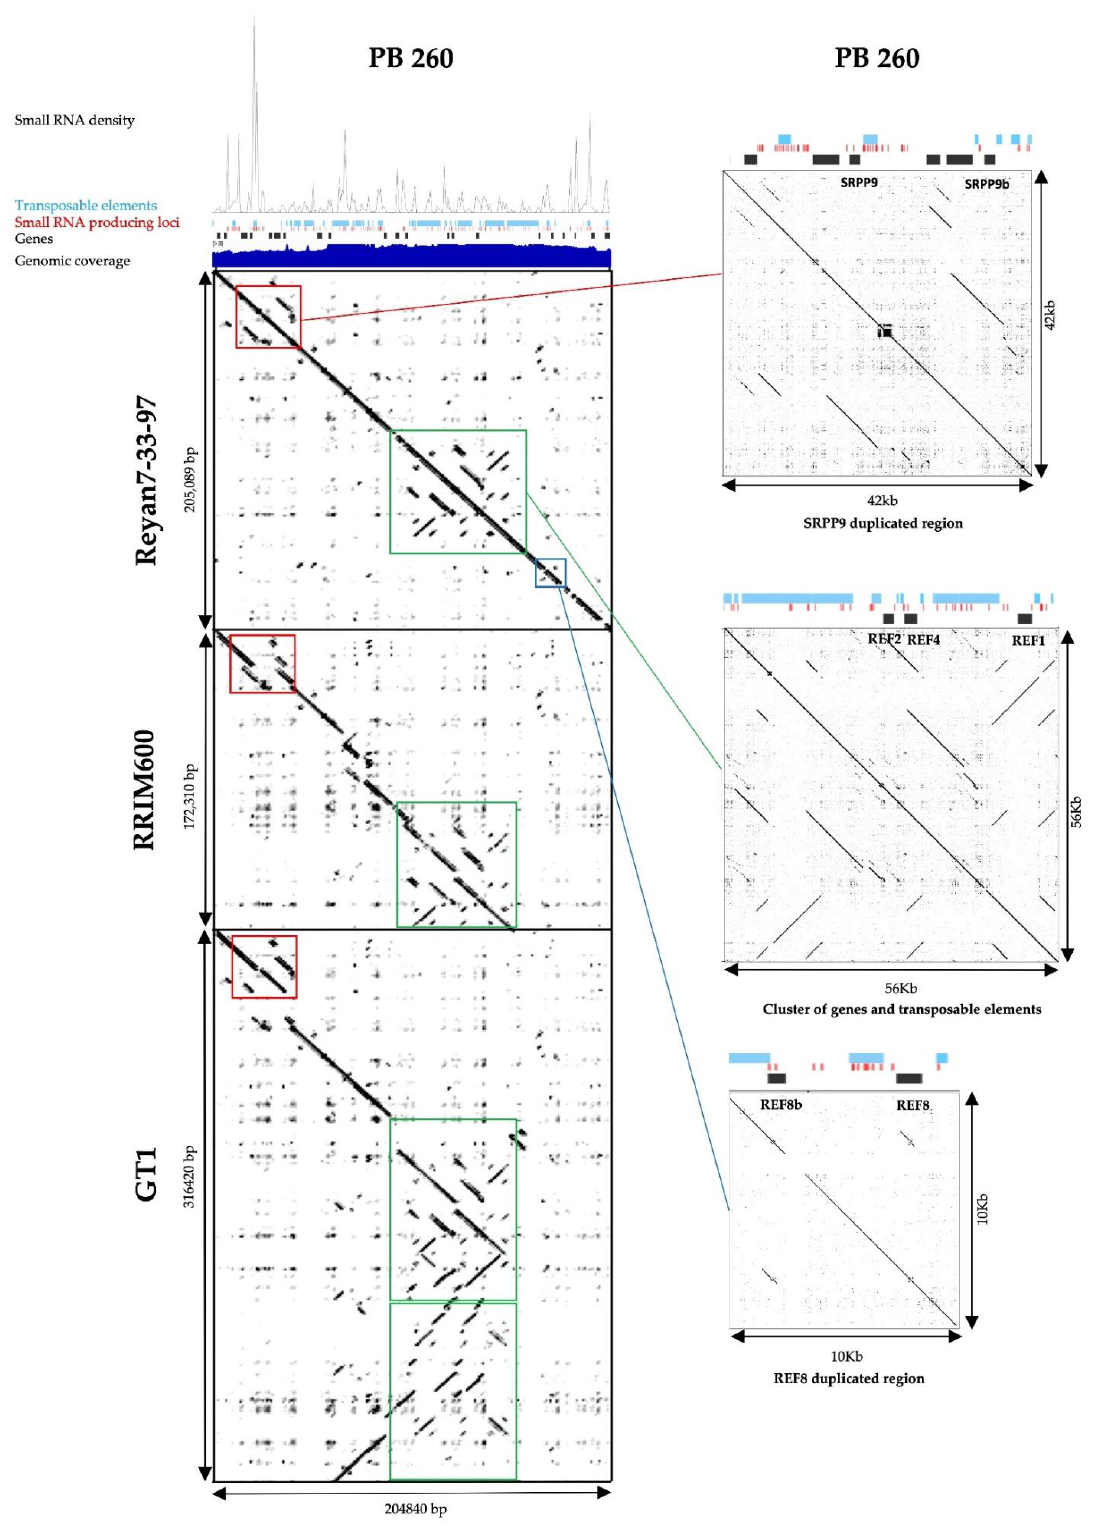
Figure 8. Scaffold 1222 sequence comparison between clones PB 260, Reyan 7-33-97, RRIM 600 and GT 1 by Dot-Plot and genomic DNA read abundance, gene, transposable elements and small RNA density (for PB 260 only). Genomic DNA reads are represented in dark blue, genes in black, transposable elements in light blue, and small RNA in red associated with their density profile. Regions of interest were zoomed in and displayed at the